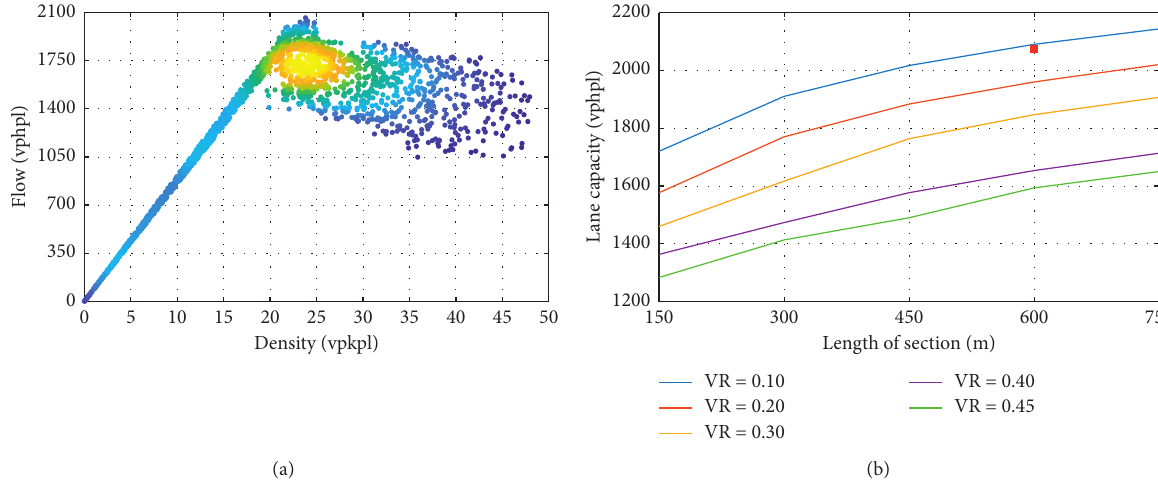
Figure 2: (a) Flow-density diagram from simulation runs with HuVs only; (b) lane capacity at varying length and VR of weaving